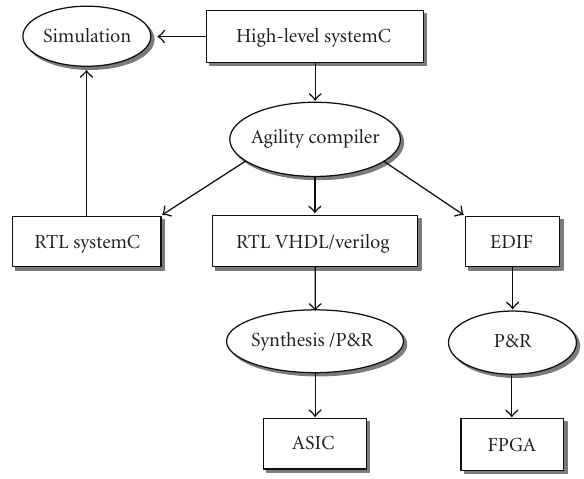
Figure 1: Agility design